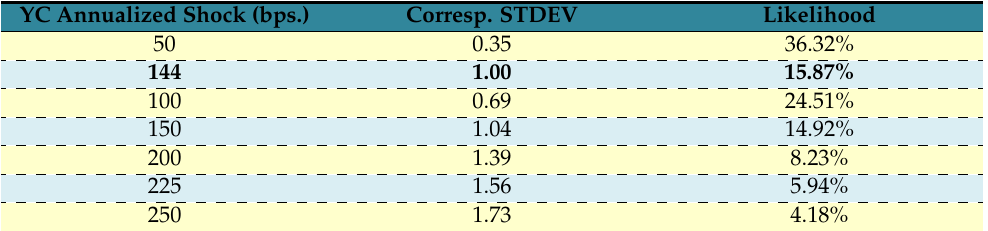
Table A2. Likelihood of principal components’ annualized yield curve shocks on 25 March 2022.